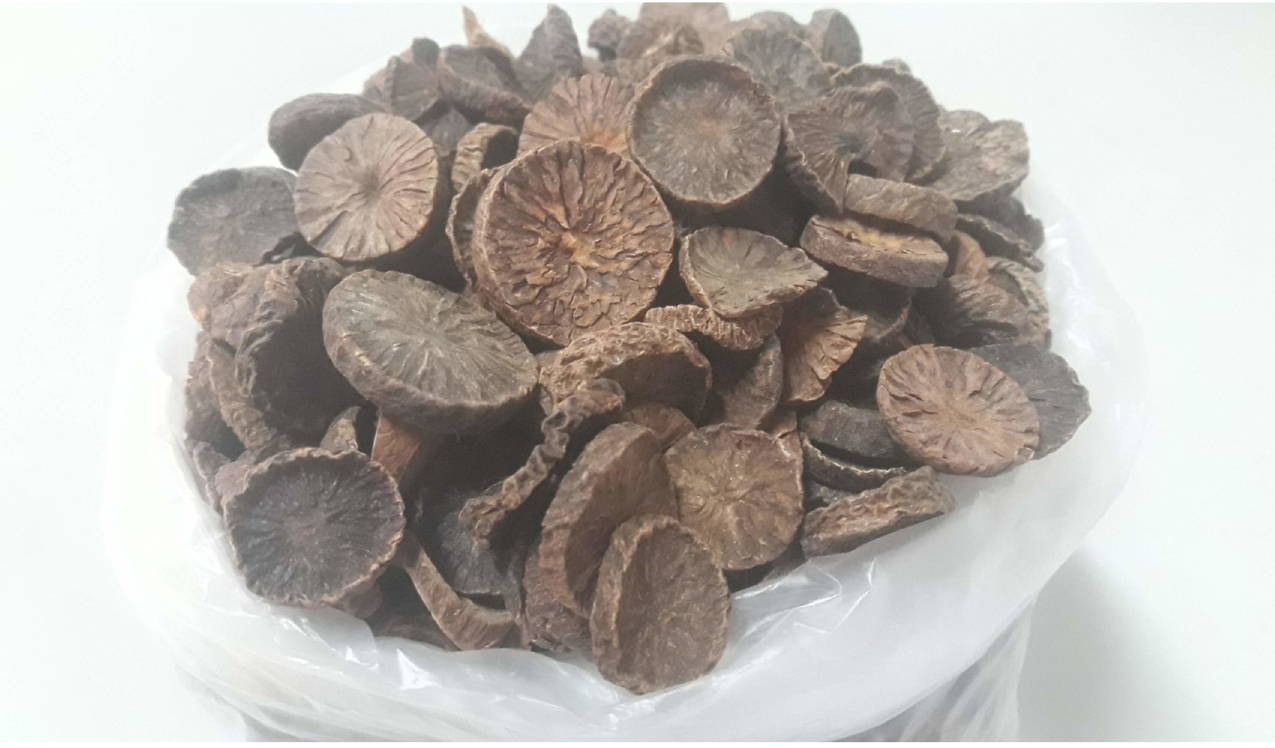
PLOS ONE | https://doi.org/10.1371/journal.pone.0260281 November29,